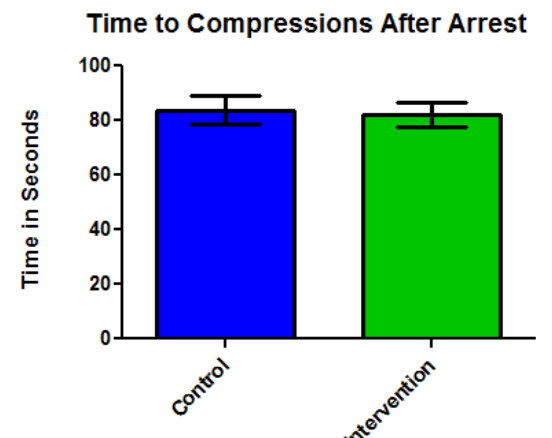
Figure 2. Students with access to computer based simulation defibrillated Ventricular Fibrillation in the ACLS Megacode 38 sec - onds faster than students without access [t(63=3.36,